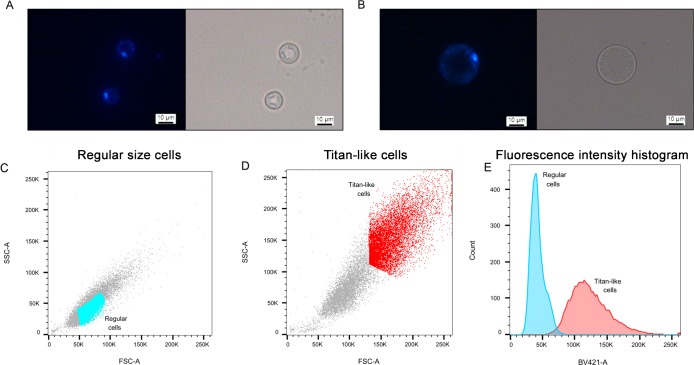
Nuclear staining of titan-like cells.Cells of regular size and titan-like cells were obtained by inoculating H99 strain in TCM at 106 and 104 cells/mL respectively. After incubating overnight at 37°C with 5% CO2, the cells were fixed and stained with DAPI as described in material and methods. A and B show the microscopic appearance of the nucleus of cells of regular size (A), and titan-like cells (B). C-E, Analysis of nuclear staining by flow cytometry. C) FFS/SSC scatter plot of cells of regular size, D) same graph of titan-like cells. In C and E, we defined a gate to clearly separate cells of regular size (cells in blue) and titan-like cells (cells in light red). The fluorescence intensity (histograms) of the cells from these two gates is represented in panel E. Blue histogram, fluorescence from the cells shown in the gate in panel C, and light red histogram, fluorescence from the cells shown in the gate in panel D.